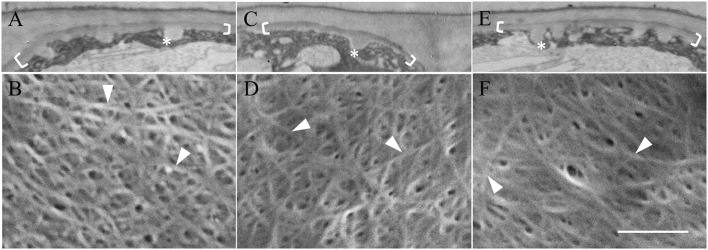
Effect of oryzalin and taxol on uniform wall layer structure and cellulose microfibril organization. Cotyledons were cultured in MS medium alone (A,B) or MS medium containing 20 μM oryzalin (C,D) or 5 μM taxol (E,F) for 15 h at 26°C following being held at 4°C for 4 h to ensure cellular uptake of the pharmacological agents before induction of ETC development on transfer to 26°C (see Zhang et al., 2015b). (A,C,E) Transmission electron micrographs of transverse sections of the outer periclinal walls of adaxial epidermal cells. Brackets mark the uniform wall layer and asterisks mark wall ingrowth (WI) papillae. (B,D,F) FESEM micrographs showing cellulose microfibrils deposited in the uniform wall layer (darts). Bar, 5 μm in (A,C,E) and 150 nm in (B,D,F).